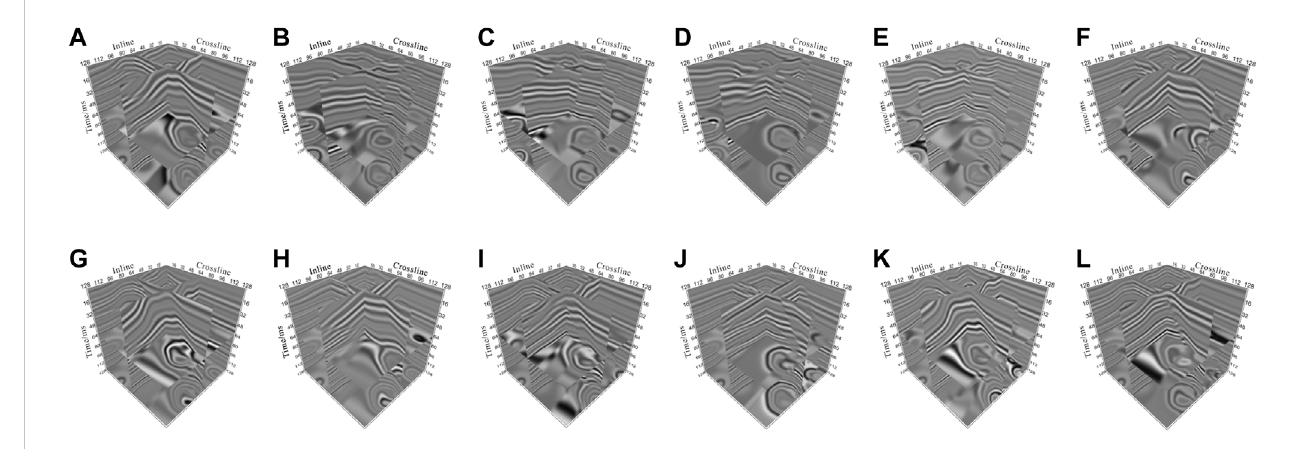
FIGURE 6 3D model of the seismic